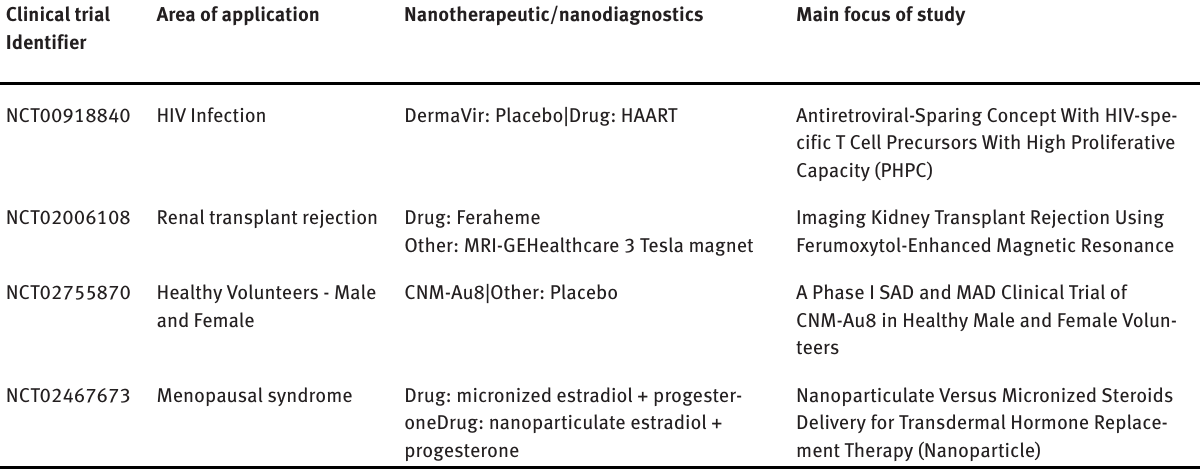
Table 5: Some of the nanobased anti-cancer drugs currently used to treat various forms of cancer